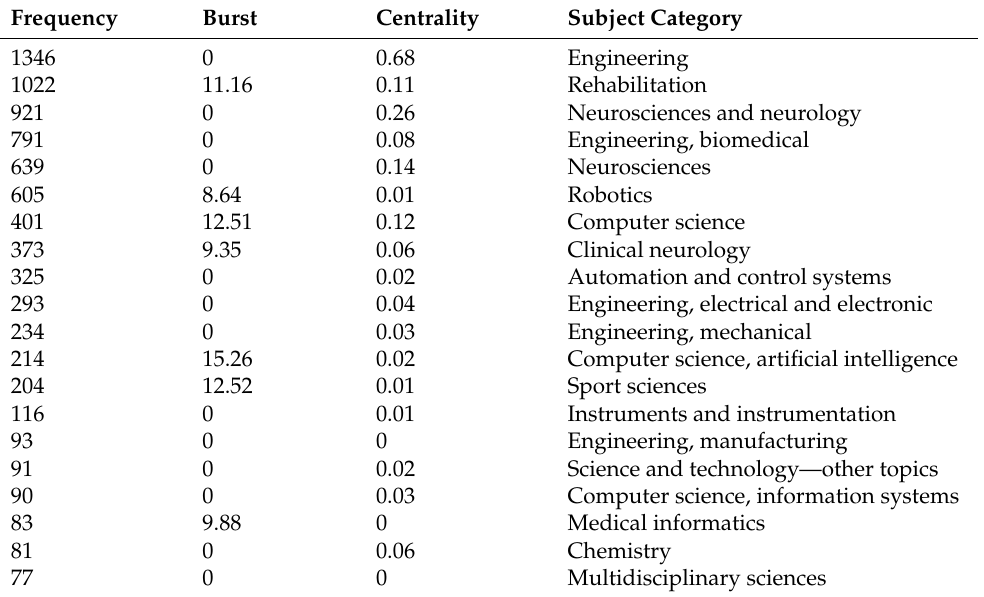
Table 1. Subject category co-occurrence